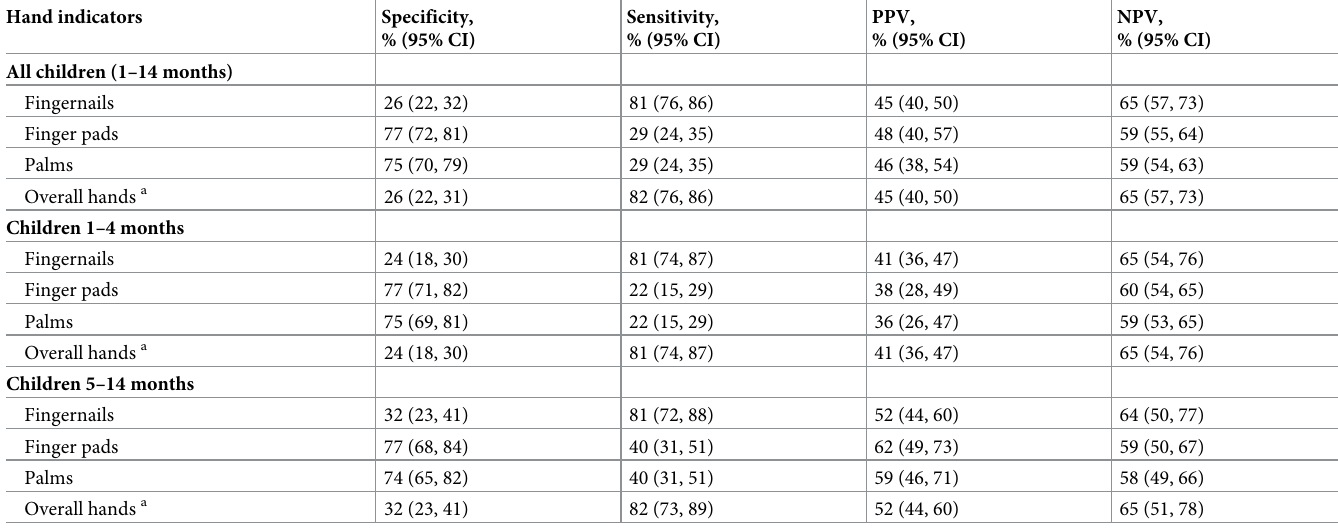
Table 3. Specificity, sensitivity, positive and negative predictive values of observed child hand cleanliness against binary E . coli presence ( < 1 MPN vs. � 1 MPN) by child age. Hand